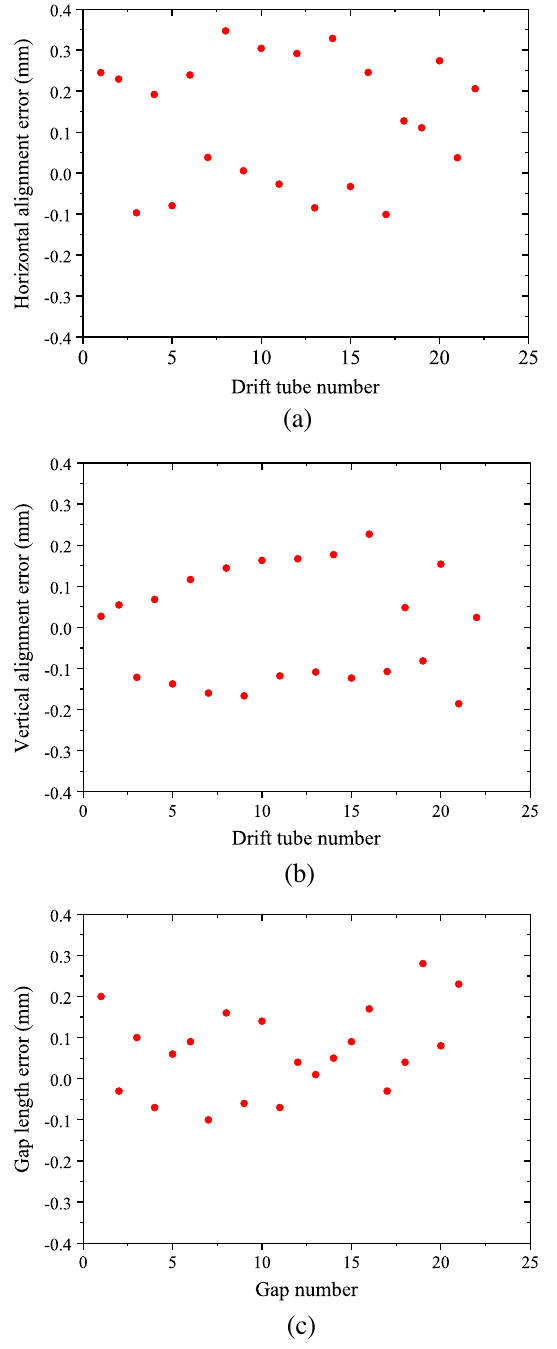
FIG. 4. Position errors of the DT centers after alignment of the DTs: (a) horizontal error; (b) vertical error; (c) gap length error.